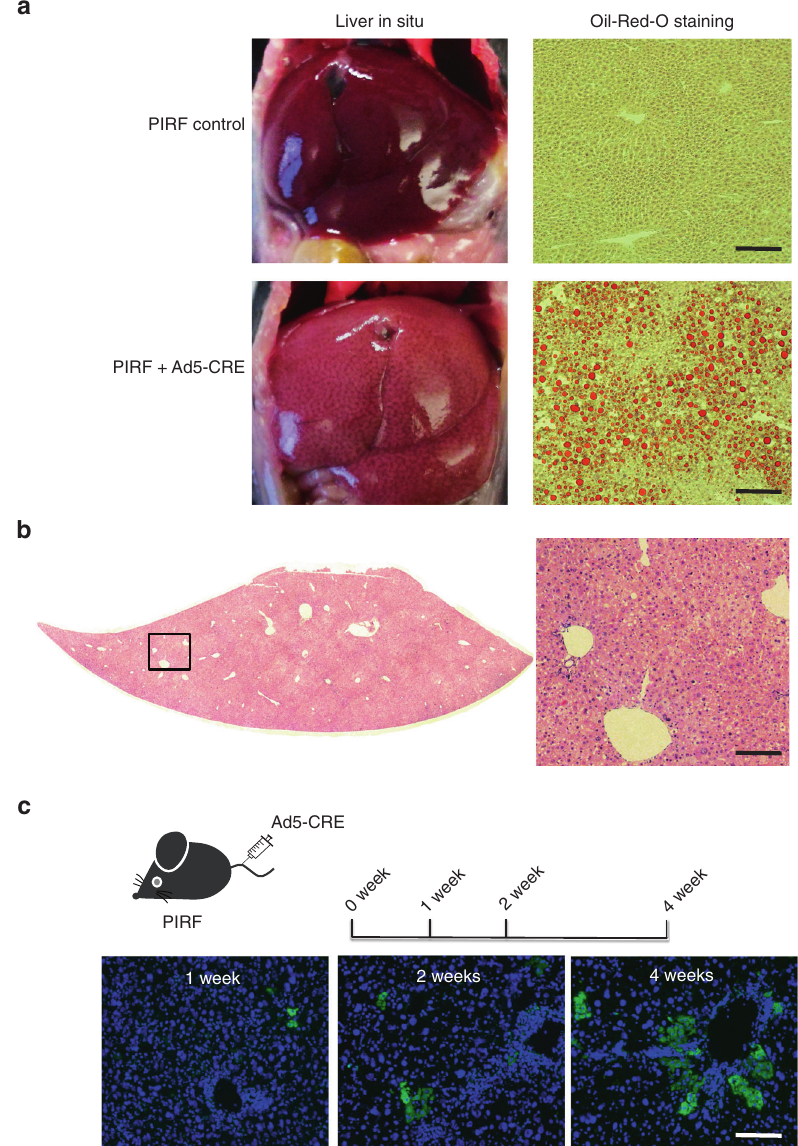
Fig. 2 Deletion of Por with an adenoviral vector expressing CRE recombinase in PIRF mice. a 2 weeks after injection of the adenovirus (2.2 × 10 10 pfu per mouse) hepatocytes start to accumulate lipids. b H&E stain of liver lobe 4 weeks after transduction with adenovirus showing macro and microvesicular steatosis. Right picture is a higher magni fi cation of boxed area on left . c Clonal expansion of Por expressing hepatocytes in PIRF mice. Mice were injected intravenously with adenovirus expressing Cre recombinase to delete the fl oxed Por gene. Scale bar 50 μ m. PIRF, Por c/c /Il2rg − / − /Rag2 − / − /Fah − /